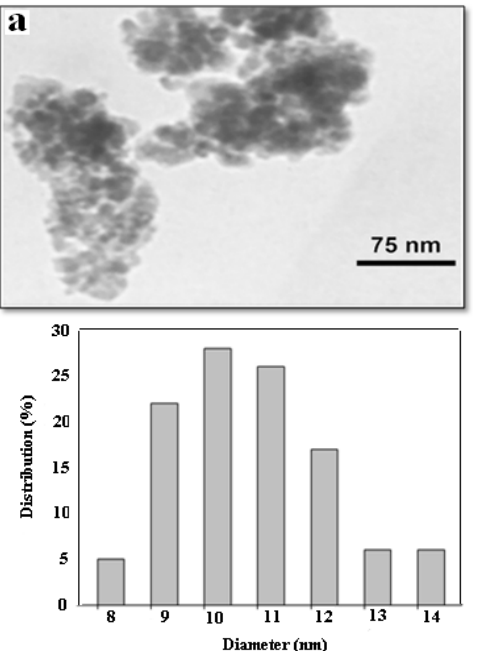
Fig. 3: (a) HR-TEM image of SPION-A-Pd(EDTA) and (b) Fig. 3 SPION-A-Pd(EDTA) particle size distribution histogram.